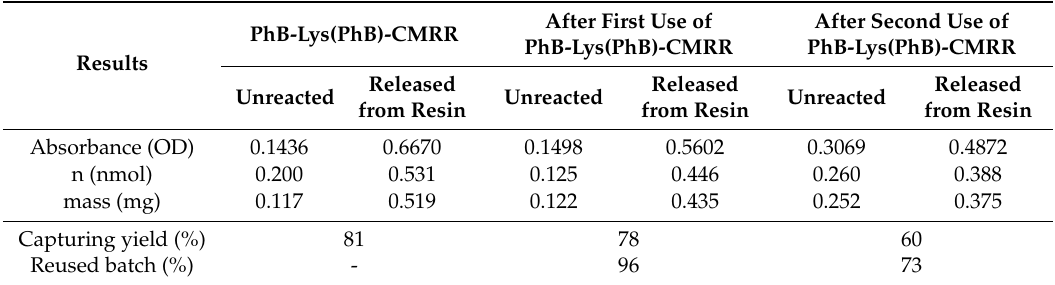
Table 2. Comparison of capturing e ffi ciency of new and reused (once or twice) batches of the PhB-Lys(PhB)-ChemMatrix ® Rink